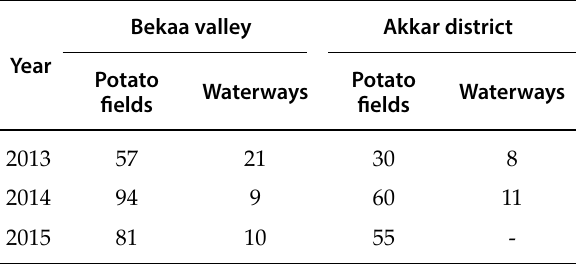
Table 1. Numbers of potato fields surveyed for brown rot and ring rot pathogens, and waterways surveyed for the brown rot pathogen, during 2013, 2014 and 2015 in the Bekaa valley and the Akkar district, Lebanon.